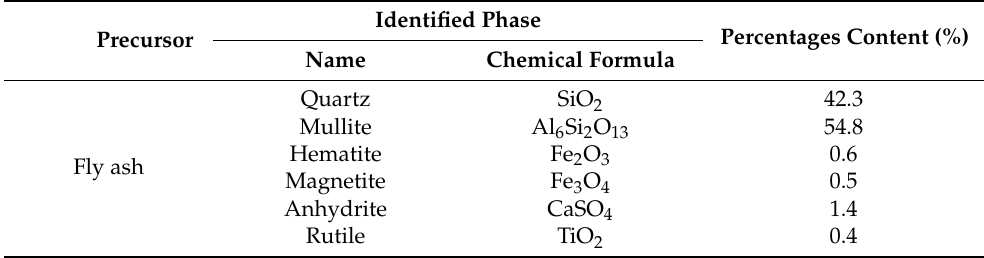
Table 1. Identified phases with their percentage share: XRD analysis results [29].